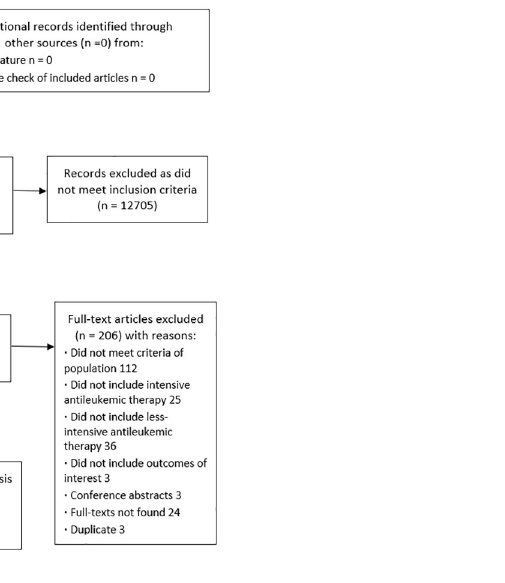
Fig 1. Eligibility assessment PRISMA flow